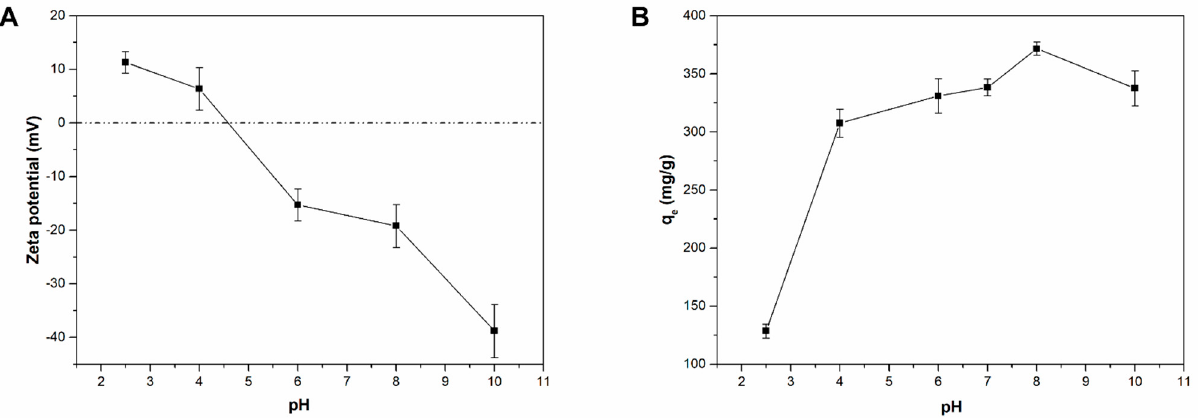
Figure 3. ( A ) Zeta potentials of Liposome@PDA microspheres at different pH. ( B ) Effect of pH on dye adsorption on Liposomes@PDA microspheres. MB concentration: 3.2 mg L − 1 ; mass of Liposome@PDA microspheres: 0.06 mg; temperature: 298 K; equilibration time: 90 min.